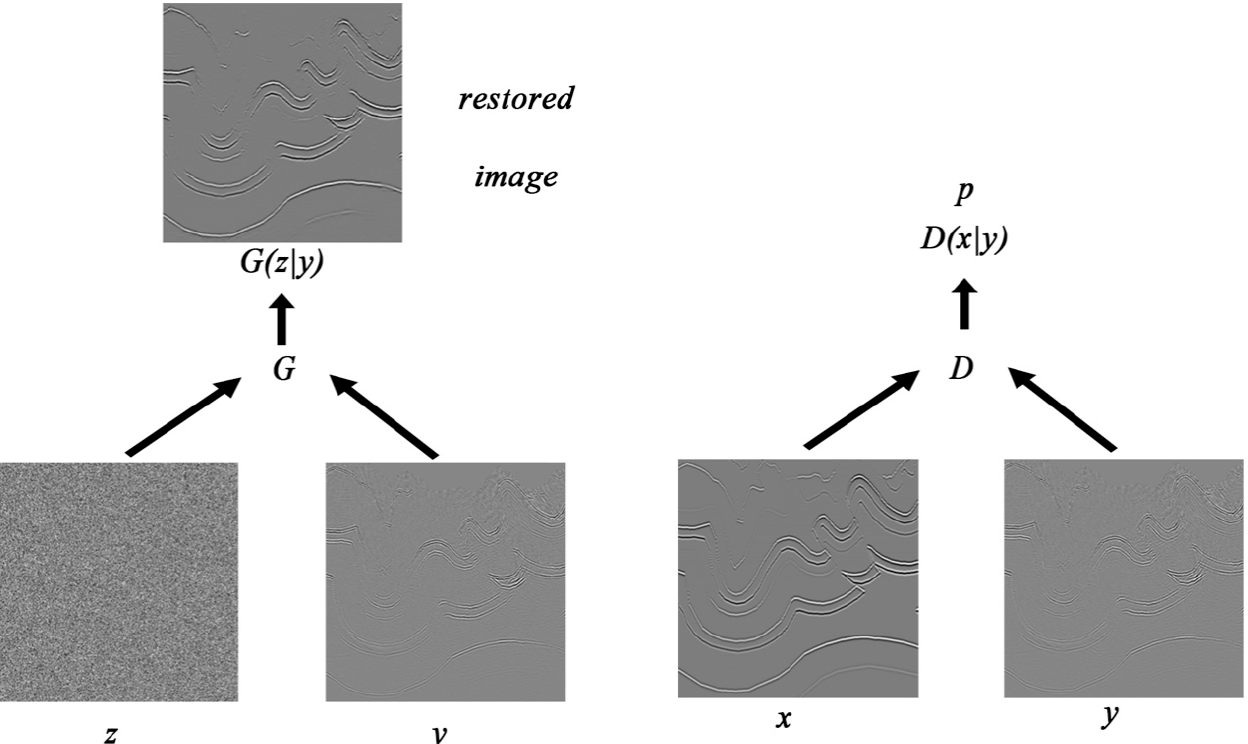
Figure 5. The training process of a conditional GAN. The generator creates a restored image G ( z | y ) from z on the condition of y . The discriminator is trained by feeding it the denoised image x and the seismic image y . The generator and the discriminator have different loss functions and are trained iteratively.